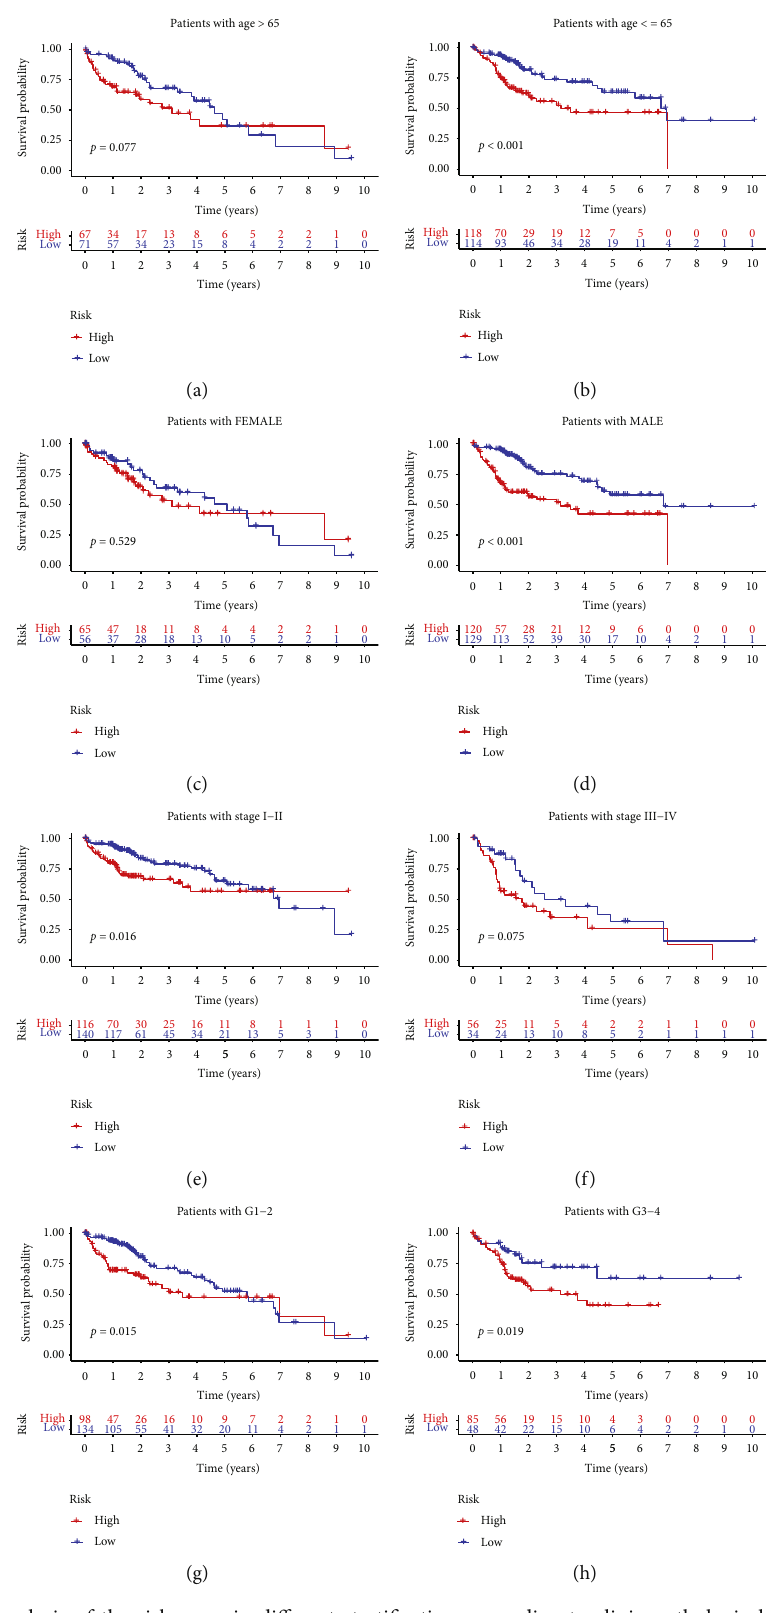
Figure 8: Kaplan-Meier analysis of the risk score in di ff erent strati fi cations according to clinicopathological characteristics. (a – h) HCC patients with varying clinical features (age, gender, stage, and grade) were analyzed using the Kaplan-Meier method according to the risk